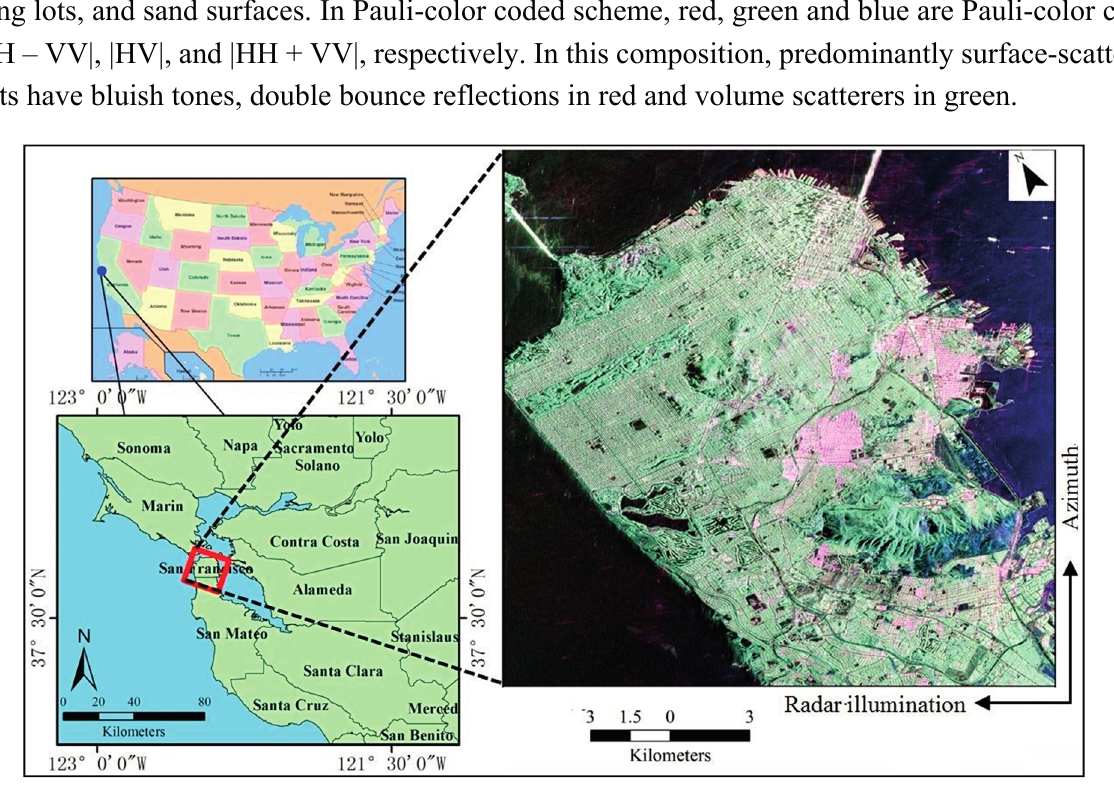
Figure 1. Study area in San Francisco and the AIRSAR L-band polarimetric image with Pauli color coding (Red: |HH – VV|, Green: |HV|, Blue: |HH +